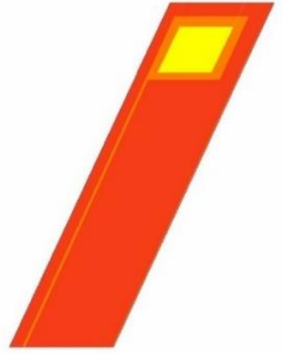
Figure 4. Micro-voltage sensor structure